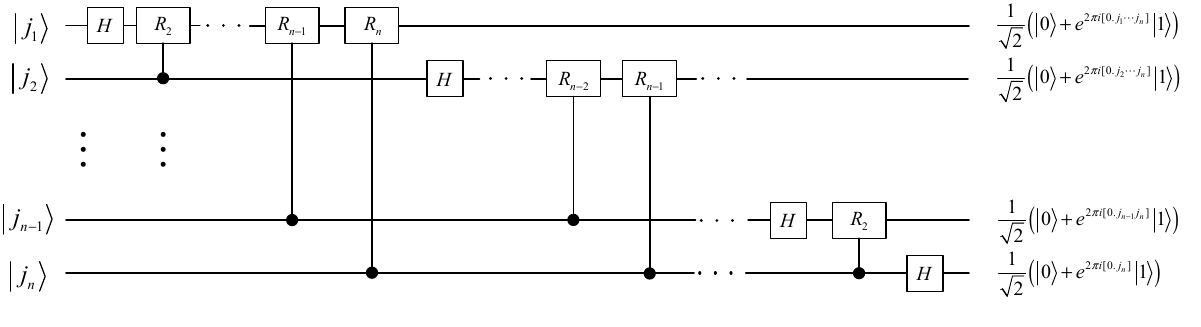
Figure 4. A circuit for the QFT .